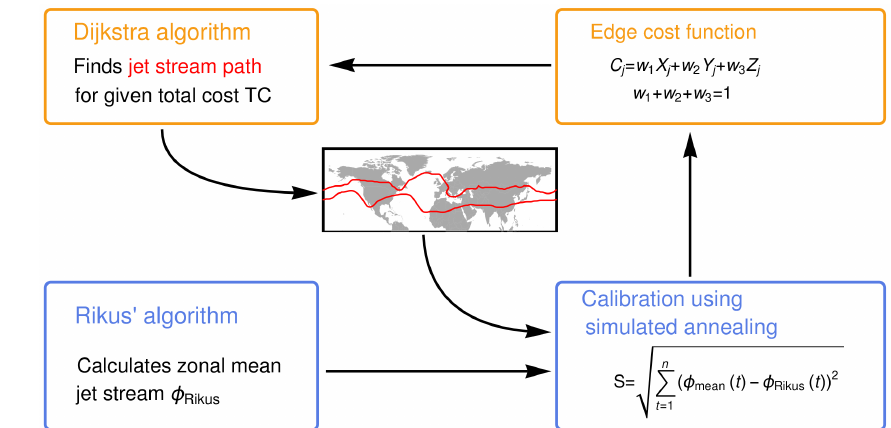
Figure 2. Calibration scheme. Before calculating the shortest path with Dijkstra’s algorithm, the cost of each edge has to be calculated according to the three terms X j , Y j and Z j . In order to find the correct weights of the terms, we calibrate them with simulated annealing and using Rikus’ algorithm to construct the skill